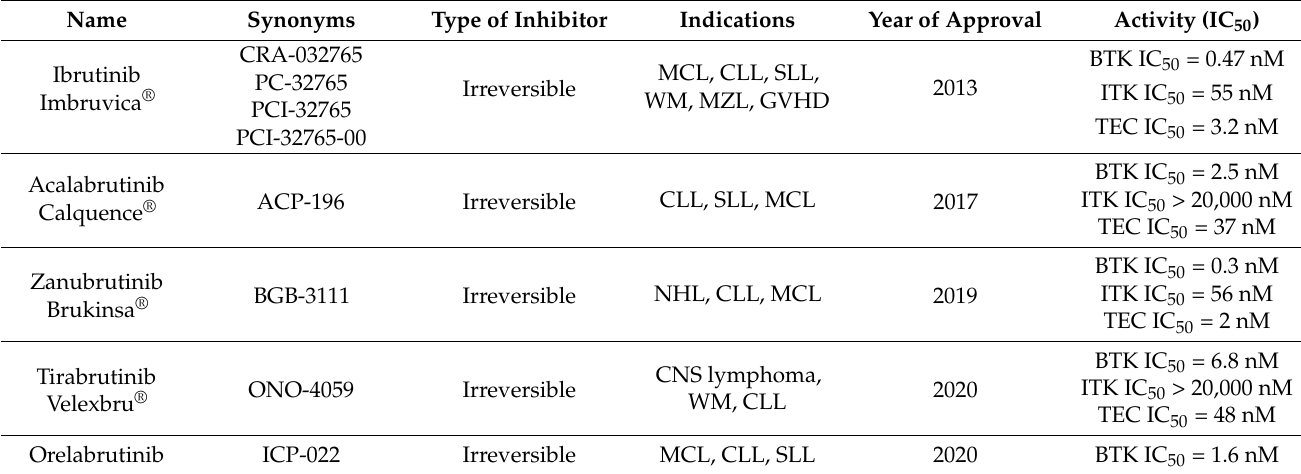
Table 1. Summary of approved BTKIs [5,14,20,75–78]